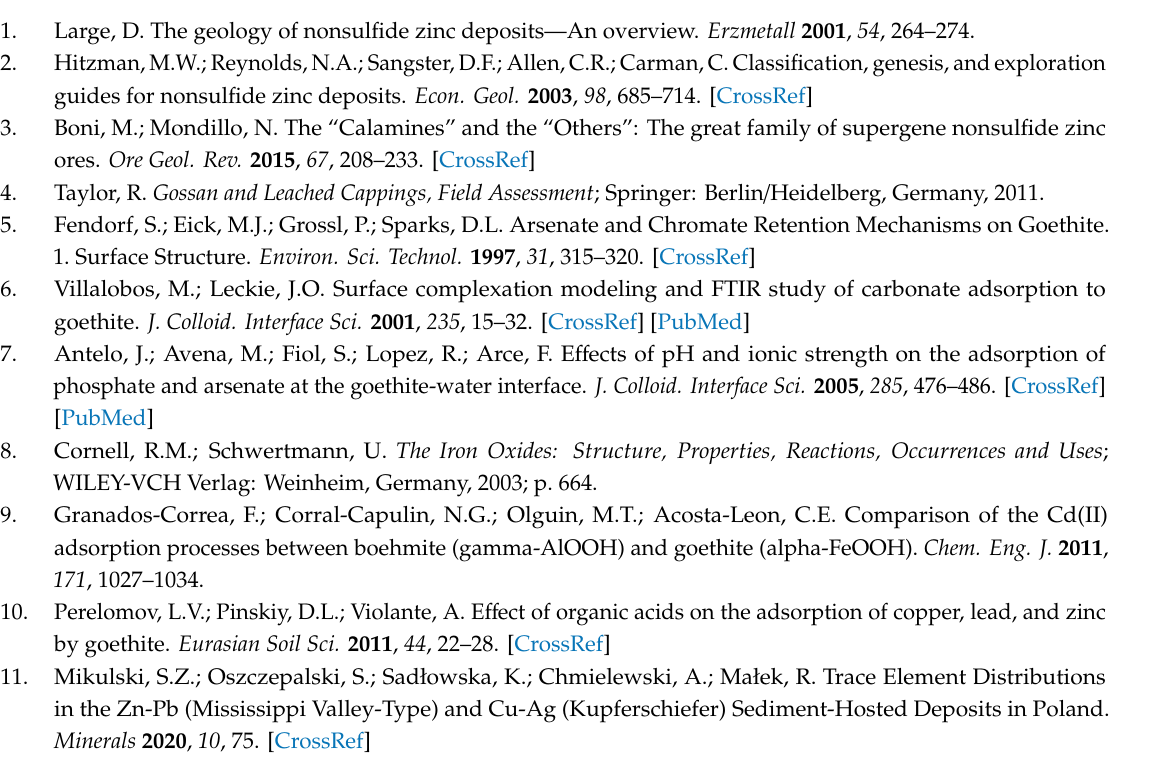
Table S1: Mineral chemistry of goethites from the Zn-nonsulfides of Cristal and Kabwe. Major and minor elements were analyzed through EMPA (wt%), while trace elements were analyzed through LA-ICP-MS (ppm), Table S2: LA-ICP-MS of hematites from Zn-nonsulfides of Kabwe, Table S3: LA-ICP-MS Secondary standard values, Table S4: Mineral chemistry of goethites from the Zn-nonsulfides of Hakkari and Jabali. Major and minor elements were analyzed through EMPA (wt%), while trace elements were analyzed through LA-ICP-MS, Table S5: Summary of Principal Component Analysis, Figure S1: Boxplots showing the chemical composition of the studied FeO / OH from Kabwe [18]: (A) Goethite from Kabwe 1 (sample ID: MI10900), (B) and (C) Goethite and hematite from Kabwe 2, respectively (sample ID: BM1930-372), Figure S2: Boxplots showing the chemical composition of the studied FeO / OH from Kabwe [18]: (A) Goethite from Kabwe 3 (sample ID: OR5305), (B) Hematite from Kabwe 3 (sample ID: OR5305), (C) Goethite from Kabwe 3 (sample ID: BM.1985,MI29629 2 / 2), (D) Hematite from Kabwe 3 (sample ID: BM.1985,MI29629 2 / 2), Figure S3: Boxplots showing the chemical composition of the studied FeO /